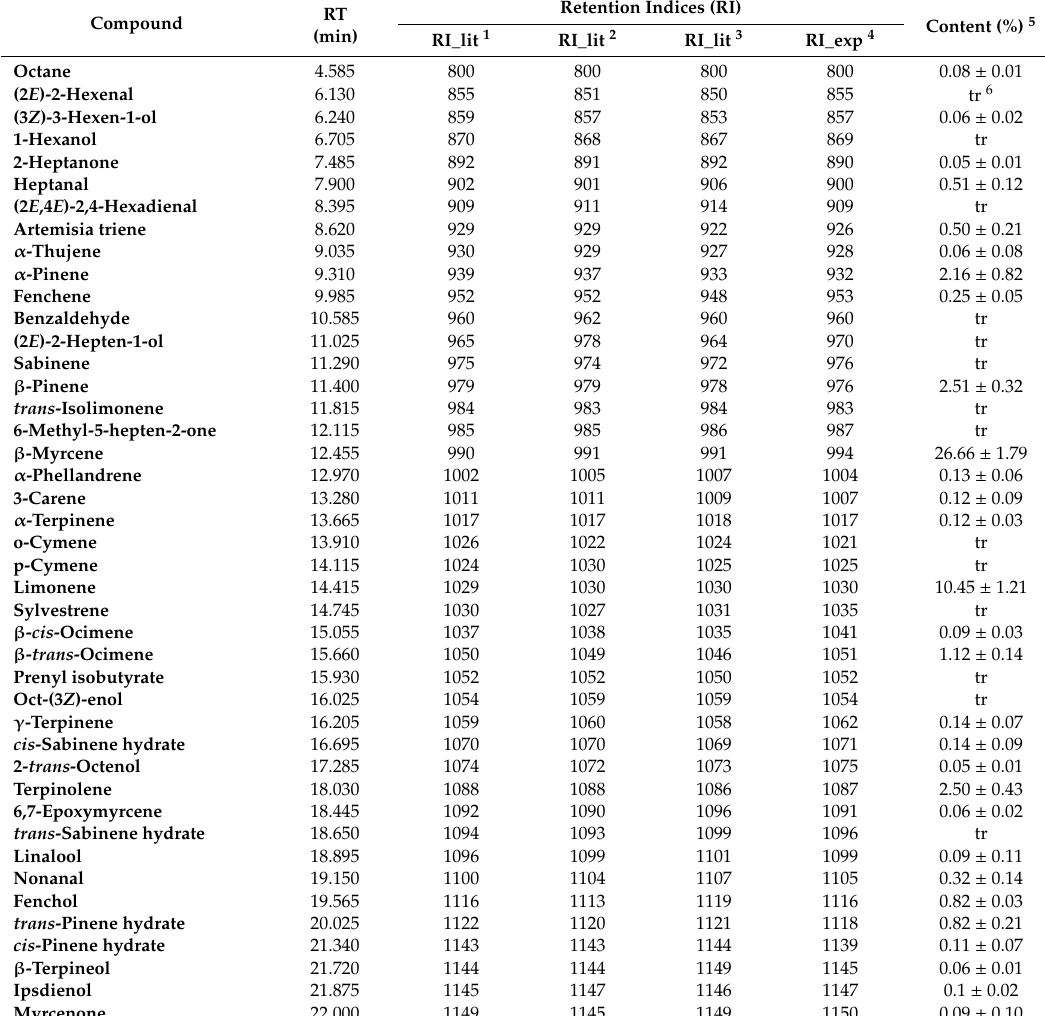
Table 3. Complete volatile constituents of fresh Cannabis sativa flowers.